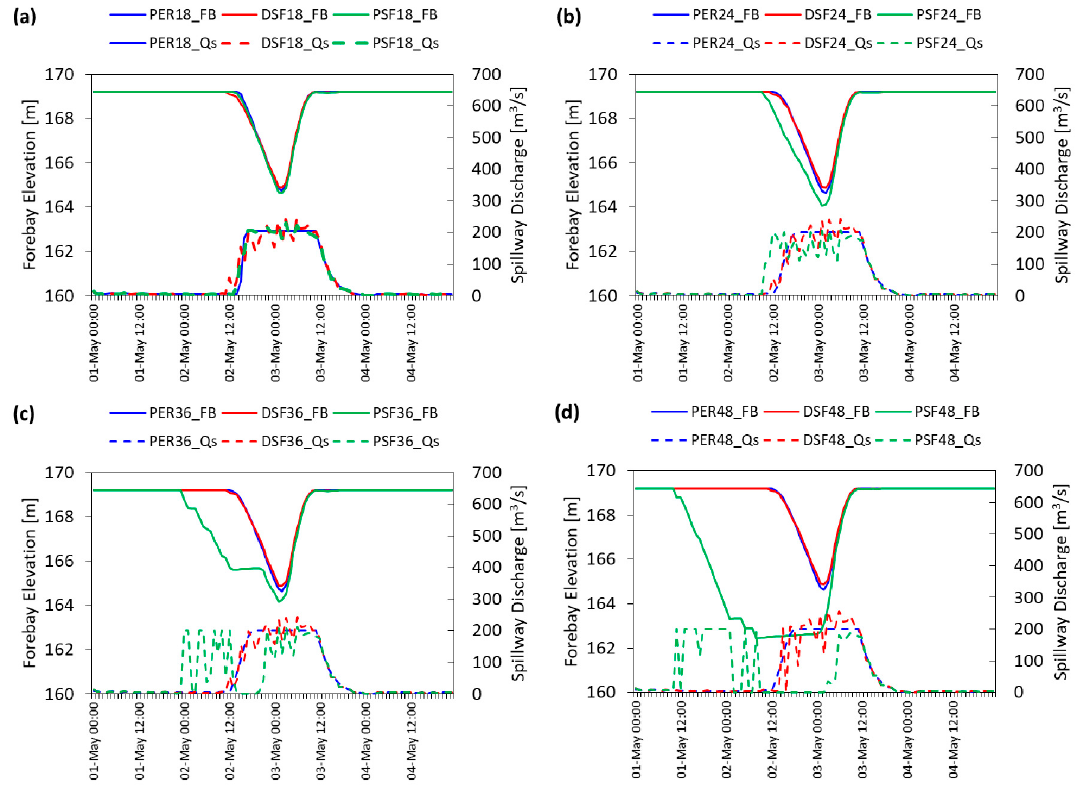
Figure 11. Comparison of deterministic (perfect and DSF) and stochastic (PSF) closed-loop MPC results with different forecast horizons (Sce-Q100a): ( a ) 18 h; ( b ) 24 h; ( c ) 36 h; ( d ) 48 h.